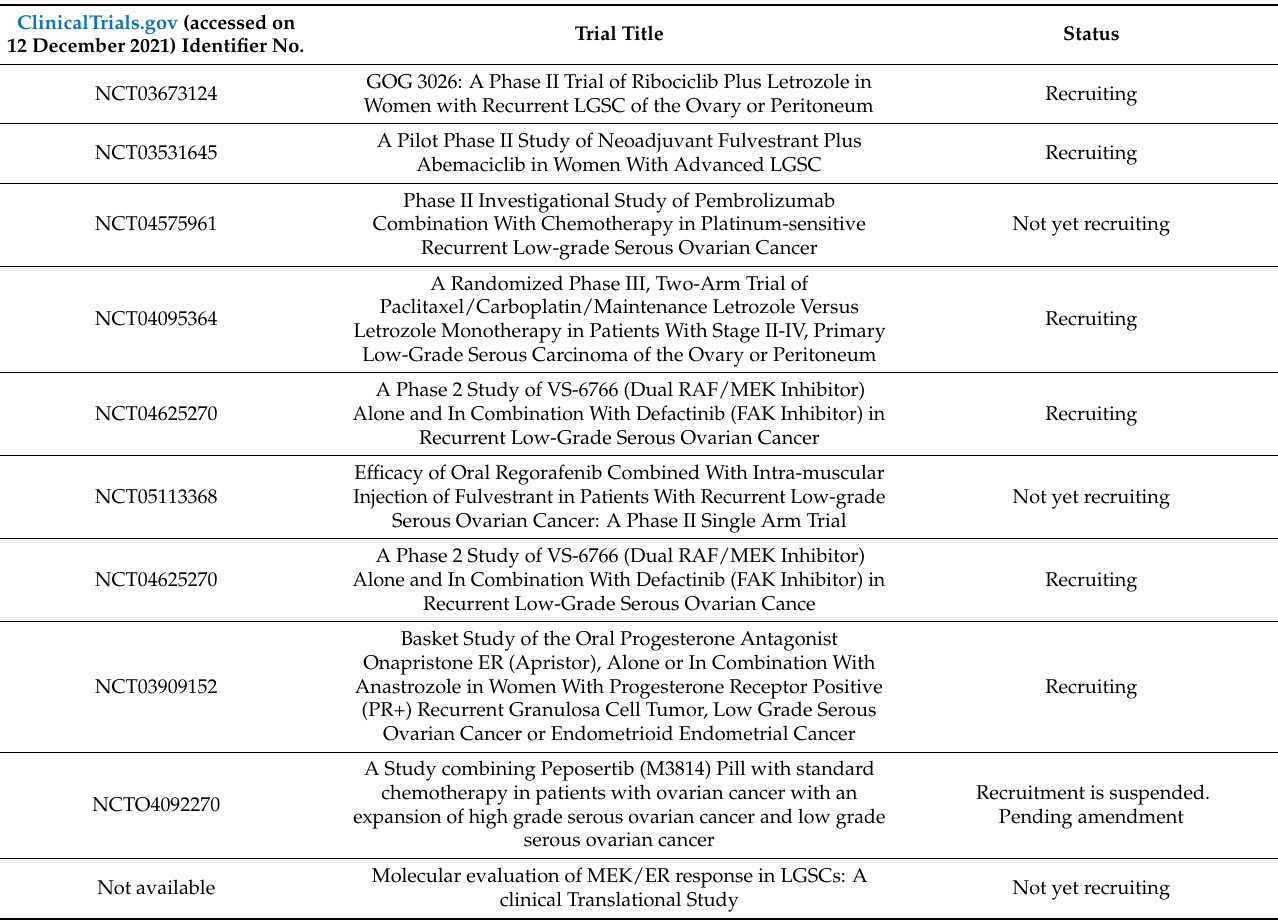
Table 5. Ongoing clinical trials in